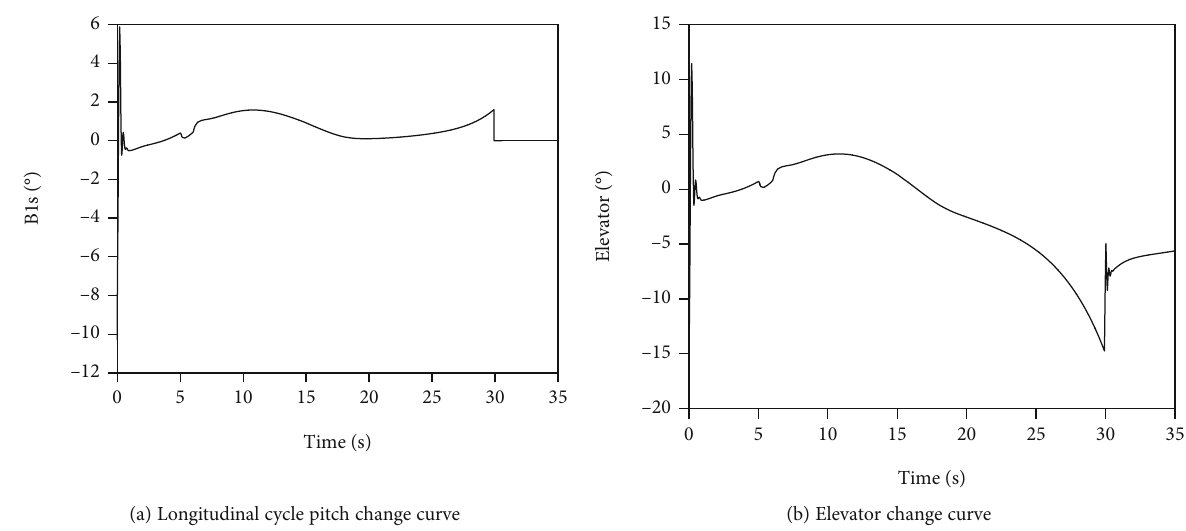
Figure 18: The control signal change